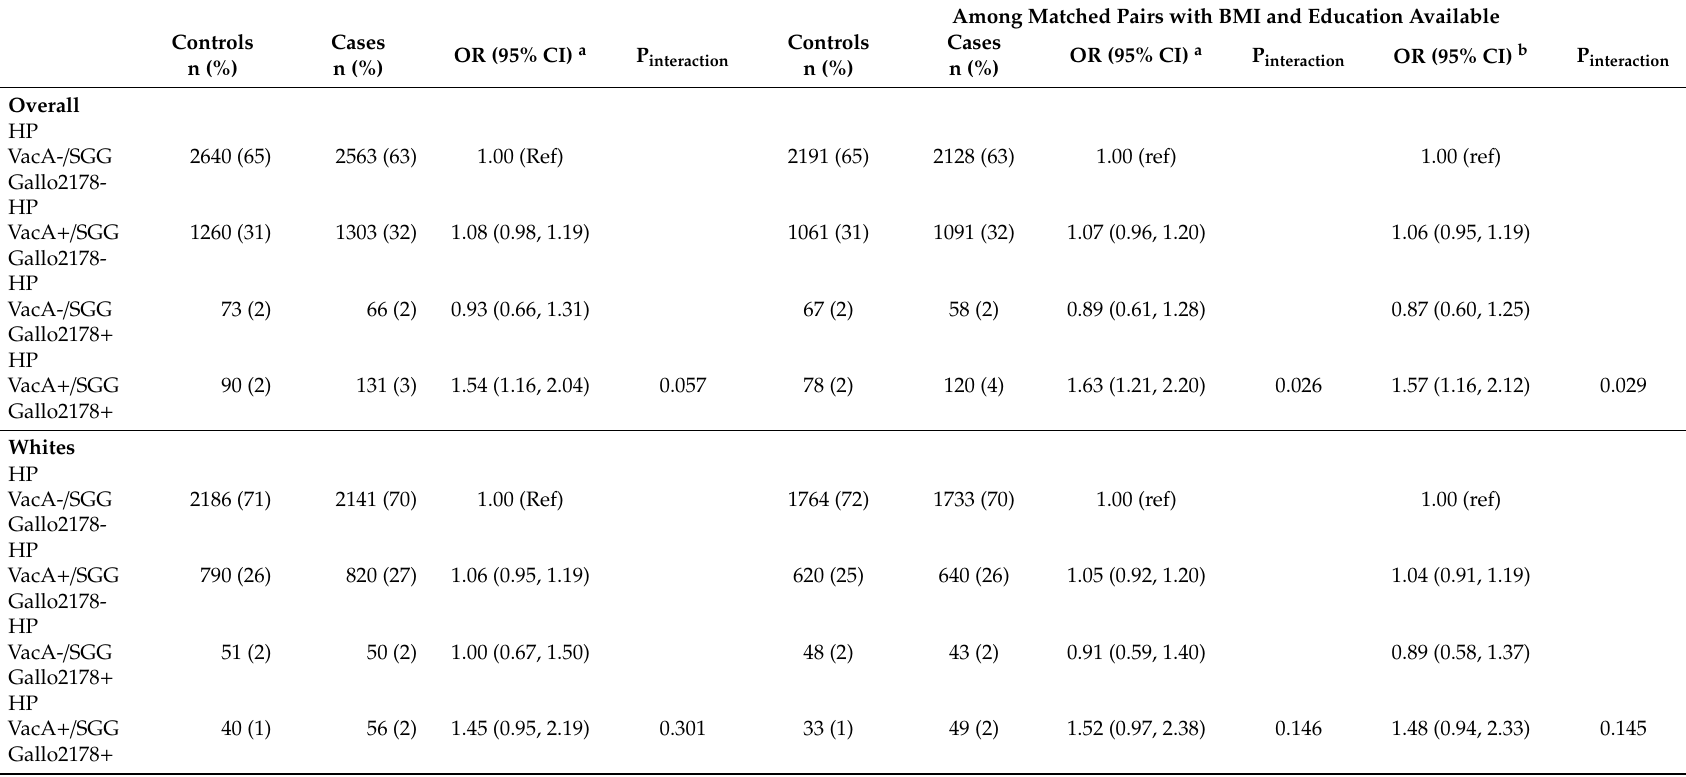
Table 2. SGG Gallo2178 and HP VacA combined status and colorectal cancer risk, overall and by self-reported race / ethnicity. Among Matched Pairs with BMI and Education